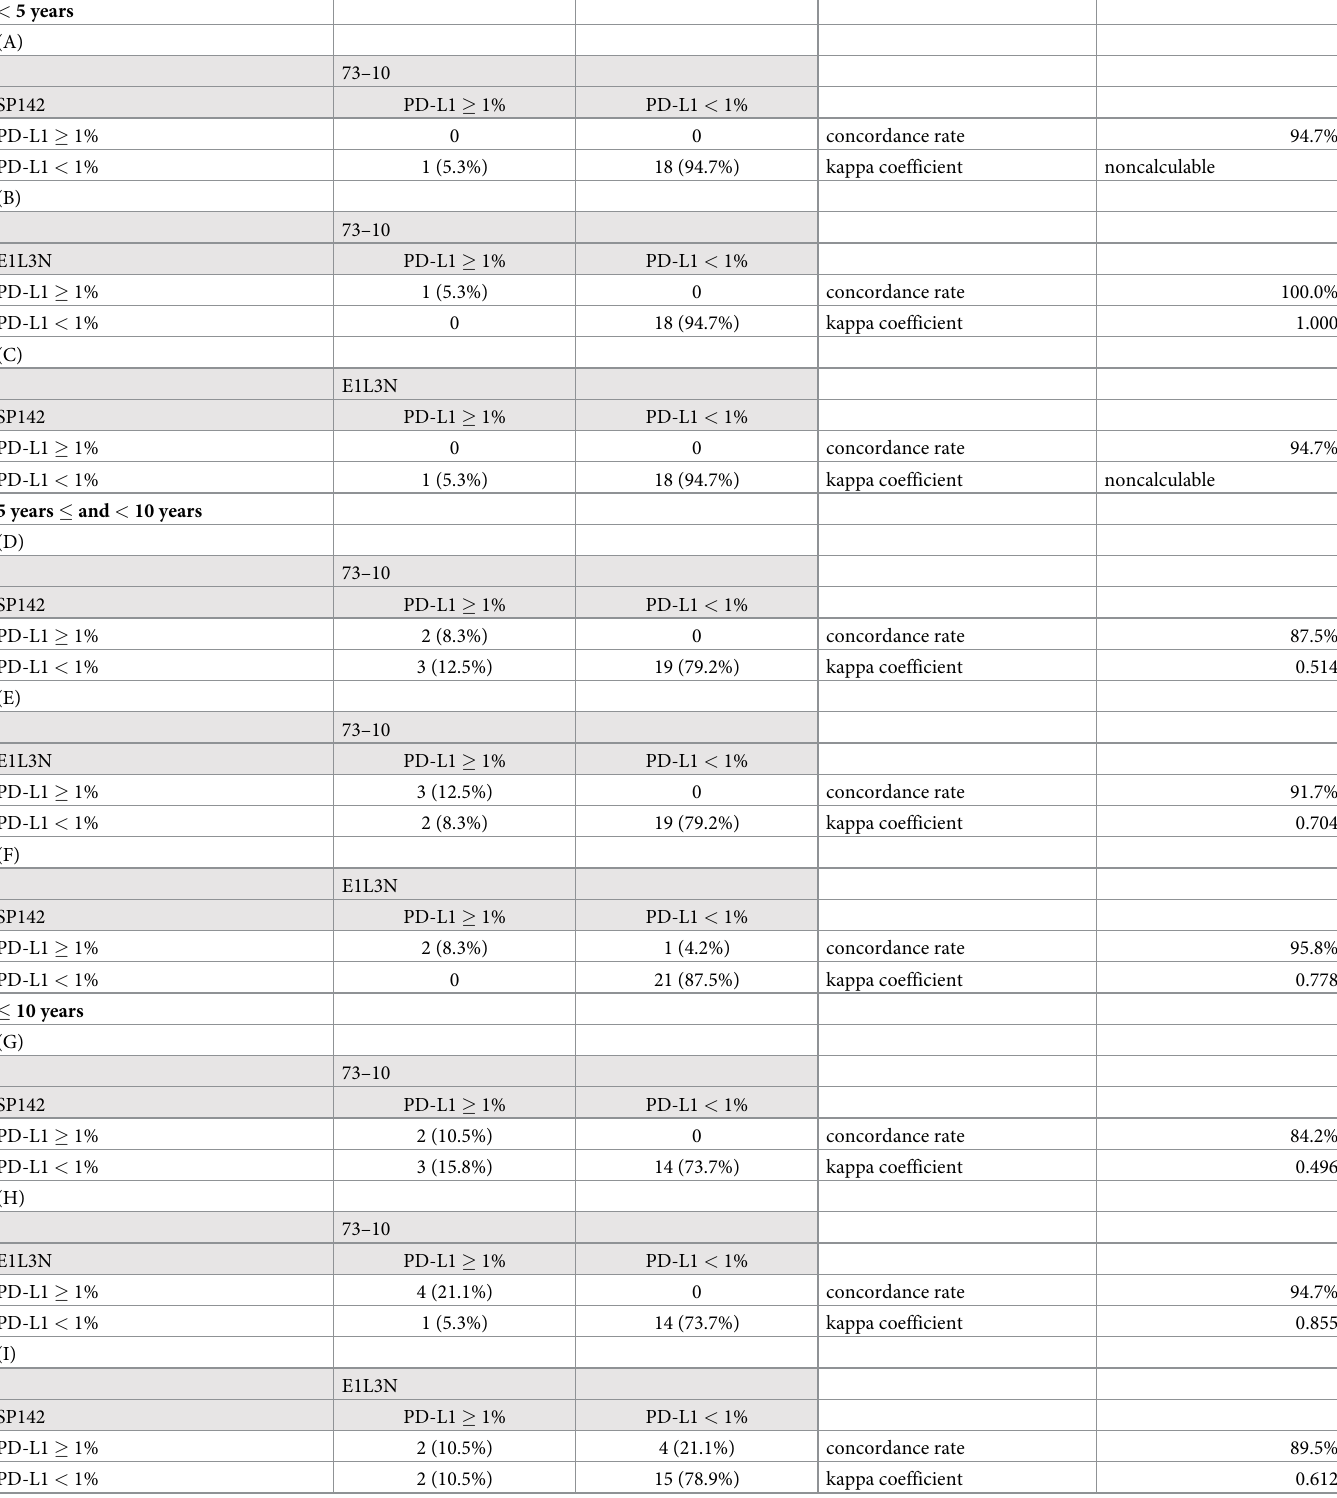
Table 5. Comparison of PD-L1 expression on TCs by 73–10, SP142, and E1L3N assays in sample